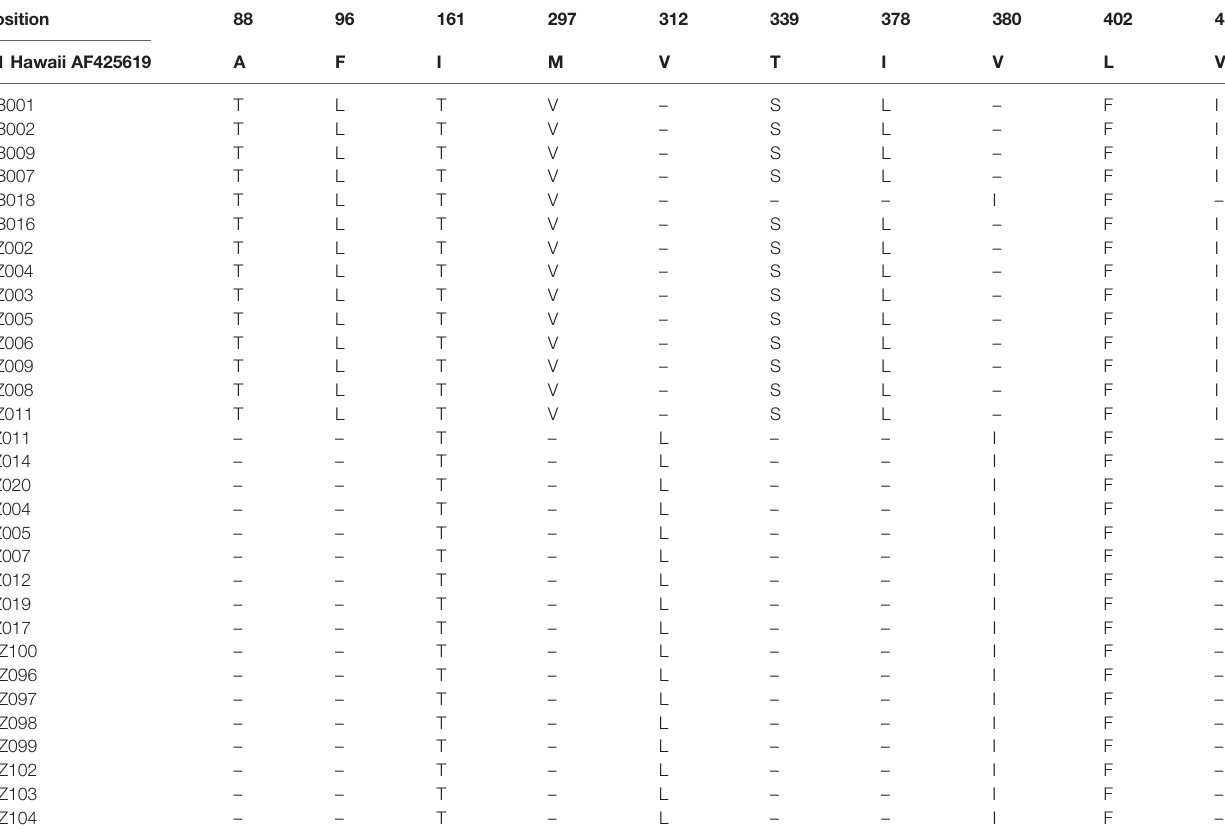
TABLE 3 | Amino acid differences in the E protein of DENV-1 strains in comparison with the D1 Hawaii reference strain (AF 425619). Position